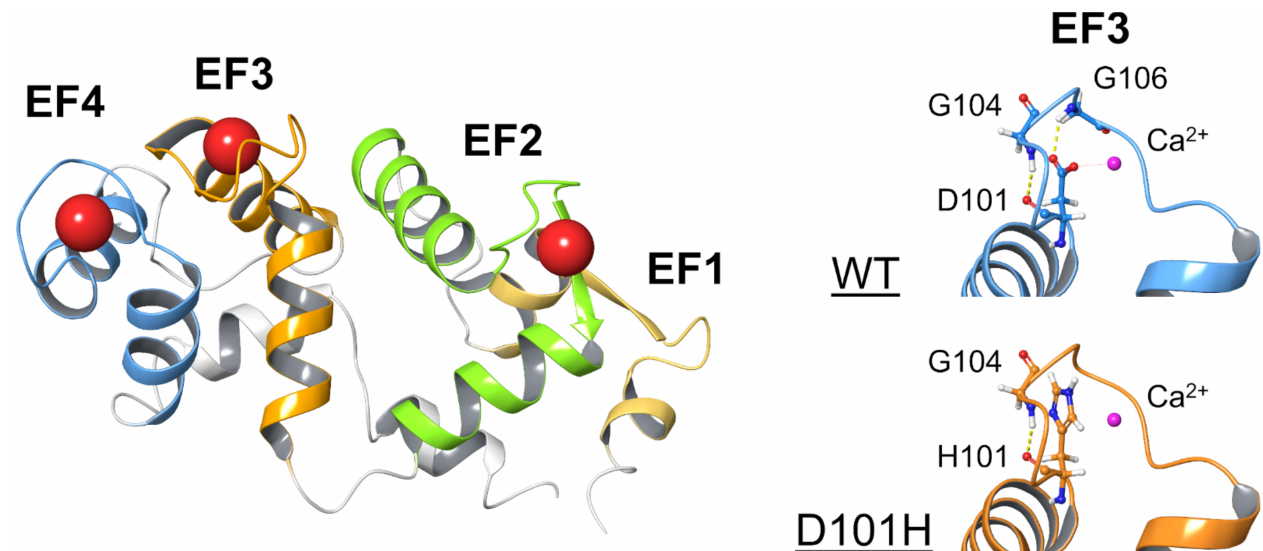
Figure 1. Structural model of D101H GCAP3 and clinical retinal imaging. Three-dimensional model ( left ) of non-myristoylated human GCAP3 in the Ca 2+ -loaded form (PDB entry: 2GGZ [7]). Protein structure is depicted as cartoon, with structural elements specifically colored (EF1 yellow, EF2 green, EF3 orange, EF4 blue) and Ca 2+ -ions represented as red spheres. Non-bonded interactions ( right ) involving D/H101 and nearby amino acids; residues are represented as sticks with H atoms in white; N atoms in blue and C atoms in red; Ca 2+ -ions are displayed as magenta spheres; H-bonds and electrostatic interactions are shown as yellow and magenta dashed lines,